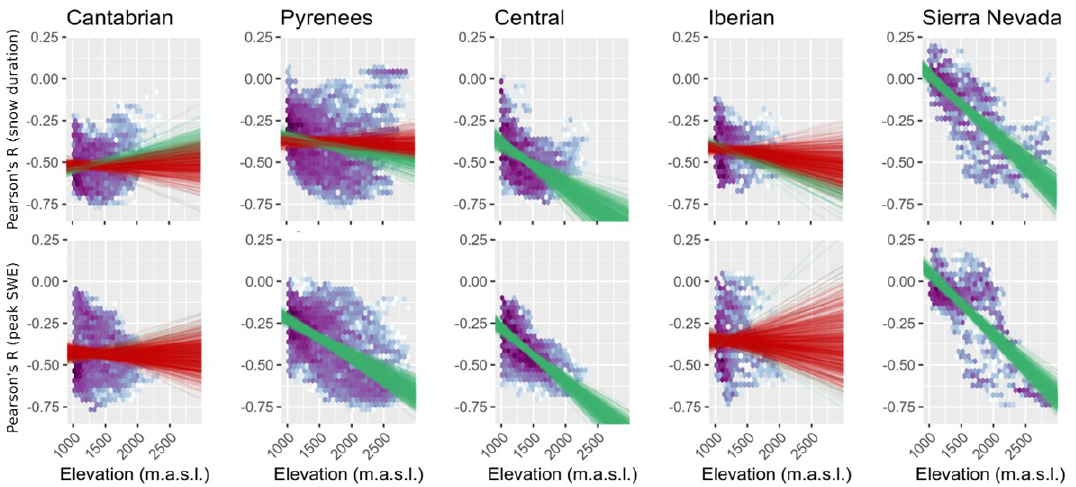
Figure 5. Influence of elevation on the correlation of the DJFM-NAO with snow duration and the peak SWE. Red lines indicate no statistical significance of the correlations of the random samples ( p -value > 0.05), while green lines show the statistically significant correlations.